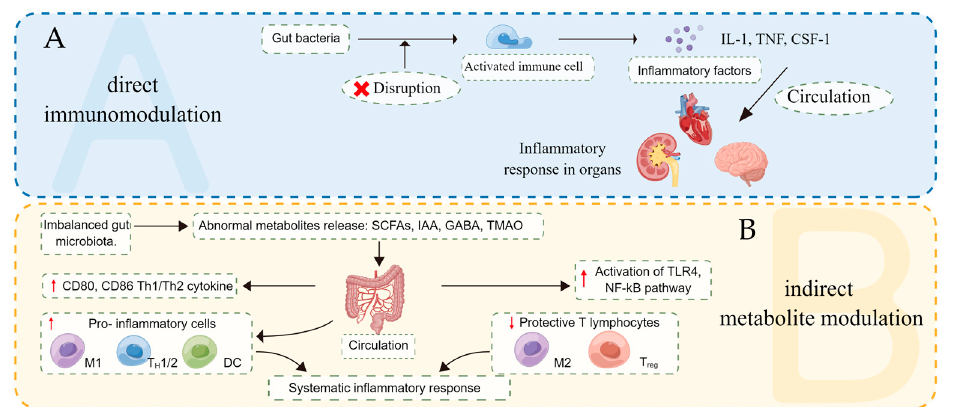
Figure 1. Two ways of regulating inflammatory response through gut microbiota. ( A ) Disrupted gut microbiota stimulate inflammatory response in damaged organs through activating immune cell and releasing pro-inflammatory cytokines. ( B ) Abnormal metabolites released by imbalanced gut microbiota facilitate inflammatory response by transforming the phenotype and function of immune cells and activating the inflammation-related pathway. IL-1: Interleukin 1; TNF: Tumor necrosis factor; CSF-1: Colony stimulating factor 1; SCFAs: Short-chain fatty acids; IAA: indoleacetic acid; GABA: Gamma-aminobutyricacid; TMAO: trimethylamine N -oxide; TLR4: Toll-like receptors 4; NF- κ B: nuclear factor- κ B; M1: type I macrophage; M2: type II macrophage; Th1/2: T helper cells type 1/2; DC: Dendritic cell; Treg: Regulatory T cells. Created with Figdraw.